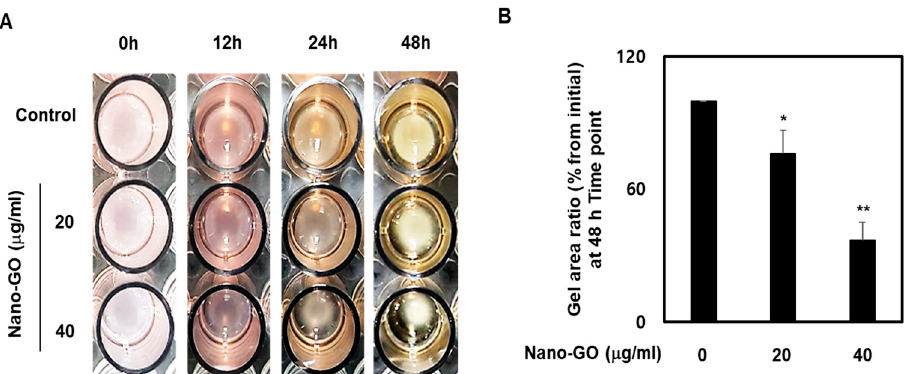
Figure 3. Effect of Nano-GO on RPE cell collagen gel contraction. The RPE cells were treated with Nano-GO (20 and 40 μ g/mL) for 48 h. Representative photo ( A ) and quantitative analysis ( B ) show the action of Nano-GO-treated or untreated RPE cells on collagen gel contraction. The gel area of each collagen gel was measured at 48 h. All data are presented as the mean ± SEM ( n = 3). * p < 0.05 and ** p < 0.01 compared to the Control.